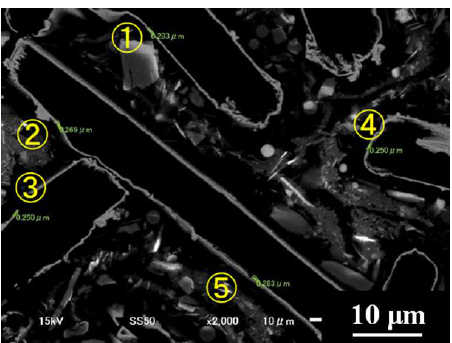
Figure 11. SEM image on a cross section of the carbon fiber plated with copper. (1–5: measurement points). Table 2. Measured thickness of the copper plate on carbon fibers. Copper Plate Thickness ( µ m)